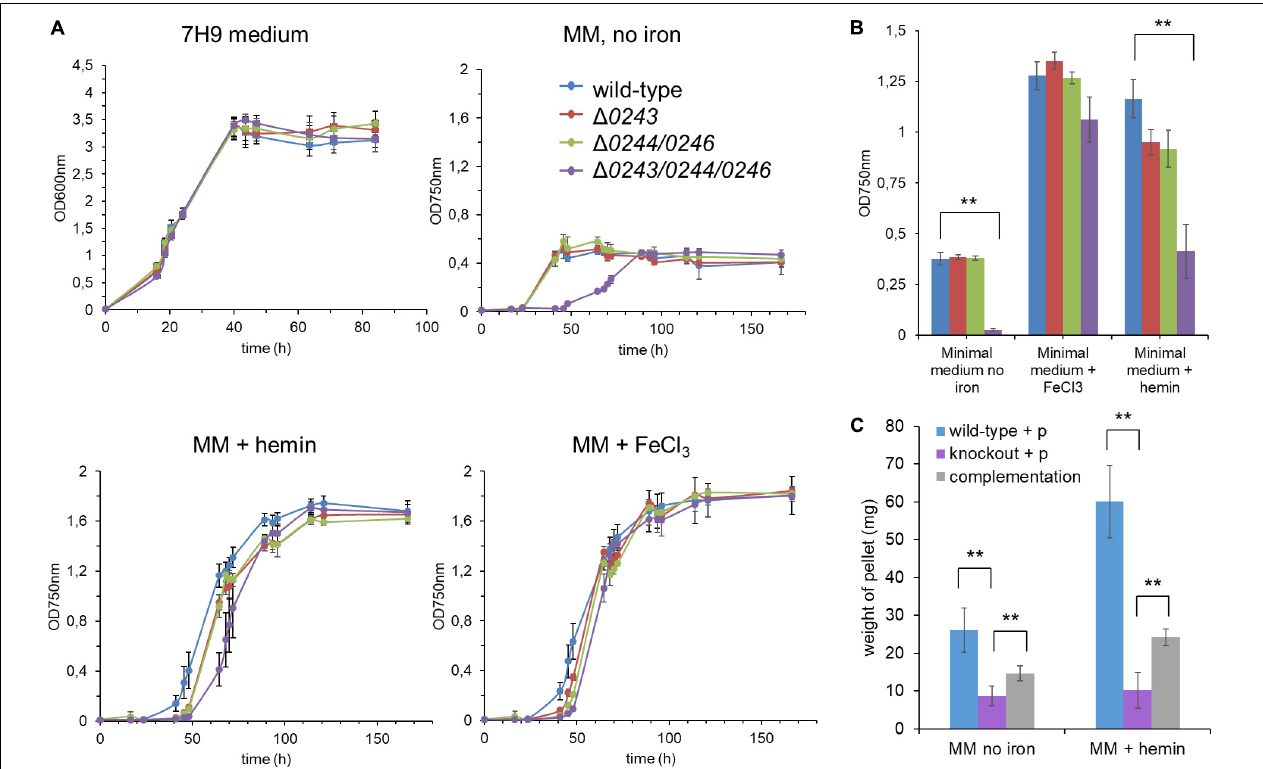
FIGURE 3 | Growth curve analysis of the mutants M. smegmatis mc 2 155 (cid:49) 0243/0244/0246, (cid:49) 0244/0246, and (cid:49) 0243 compared to wild-type cells. (A) Growth was recorded in classical mycobacterial broth “7H9 medium” and optical density was recorded at 600 nm. After 5 rounds of iron starvation, strains were grown in minimal medium (modified Sauton’s medium, MM), either iron free, in 1 µ M FeCl 3 or 1 µ M hemin supplement to determine growth dependence on the supplied iron source. Optical density was recorded at 750 nm due to partial hemin absorbance at 600 nm. (B) Summary of the growth curve results at the mid-log growth time point in modified Sauton’s medium (@ 45 h for iron free condition and @ 65 h for + iron/+ hemin conditions). Mutant strain (cid:49) 0243/0244/0246 shows significantly reduced growth in hemin as sole iron source and in iron free conditions (ANOVA-Test, ** p ≤ 0.05). (C) Growth in modified Sauton’s medium + hemin and in iron free conditions was partially restored in the complemented strain. Due to extensive clumping of the complemented strain during iron starvation and subsequent growth in minimal medium supplemented with hemin or no iron source, growth was assessed by determination of dry weight of the resulting pellet. Clumping was not fully resolved by mechanical disruption or related methods. Wild-type + p: M. smegmatis mc 2 155:pJAK1.A; knockout + p: M. smegmatis mc 2 155 (cid:49) 0243/0244/0246 :pJAKA.1 and complementation: M. smegmatis mc 2 155 (cid:49) 0243/0244/0246 :pJAKA.1_ 0243/0244/0246 . All experiments were performed in triplicates. Error bar represents ± SEM. Blue: wild-type, red: (cid:49) 0243, green: (cid:49) 0244/0246 , purple: (cid:49) 0243/0244/0246 , gray: complementation of (cid:49)